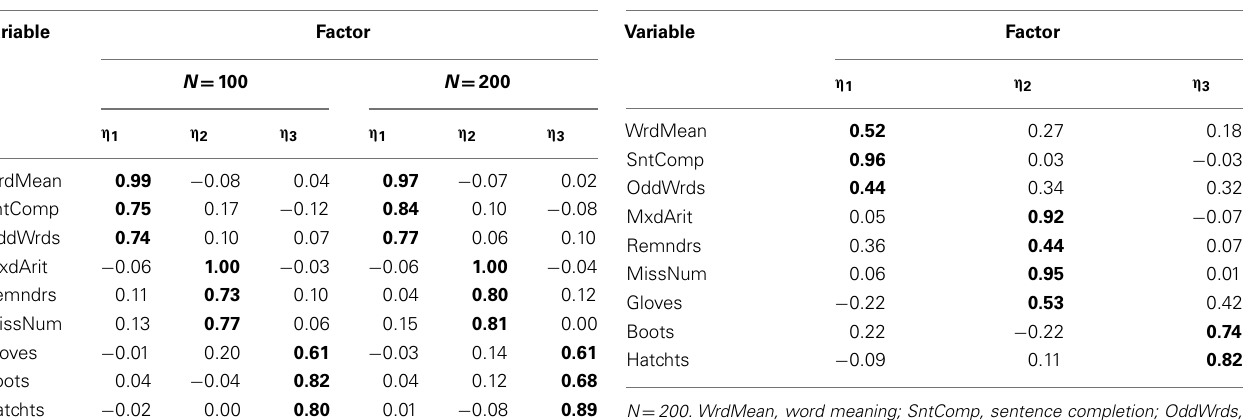
Table 15 |Three-factor model loading matrix obtained with EFA of polychoric R among Case 2 item-level variables.